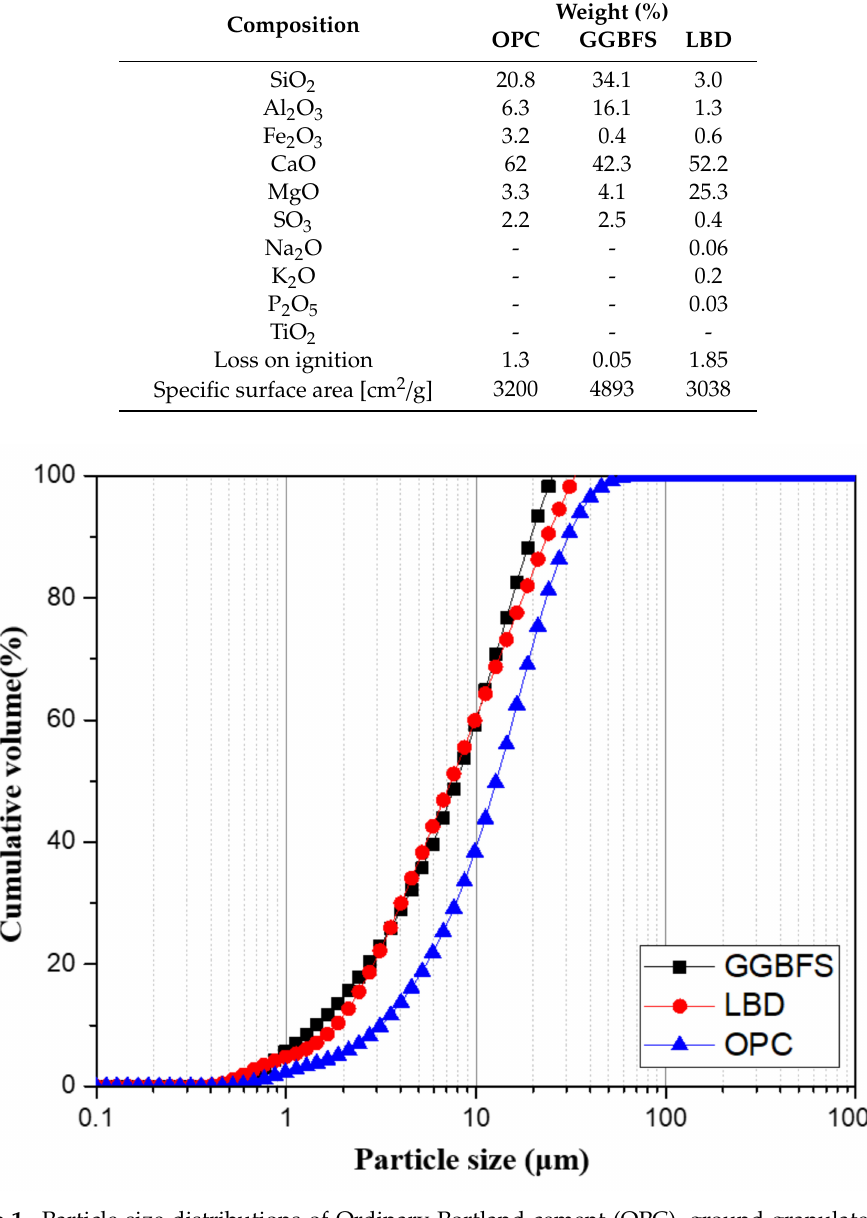
Figure 1. Particle size distributions of Ordinary Portland cement (OPC), ground granulated blast furnace slag (GGBFS), and light-burnt dolomite